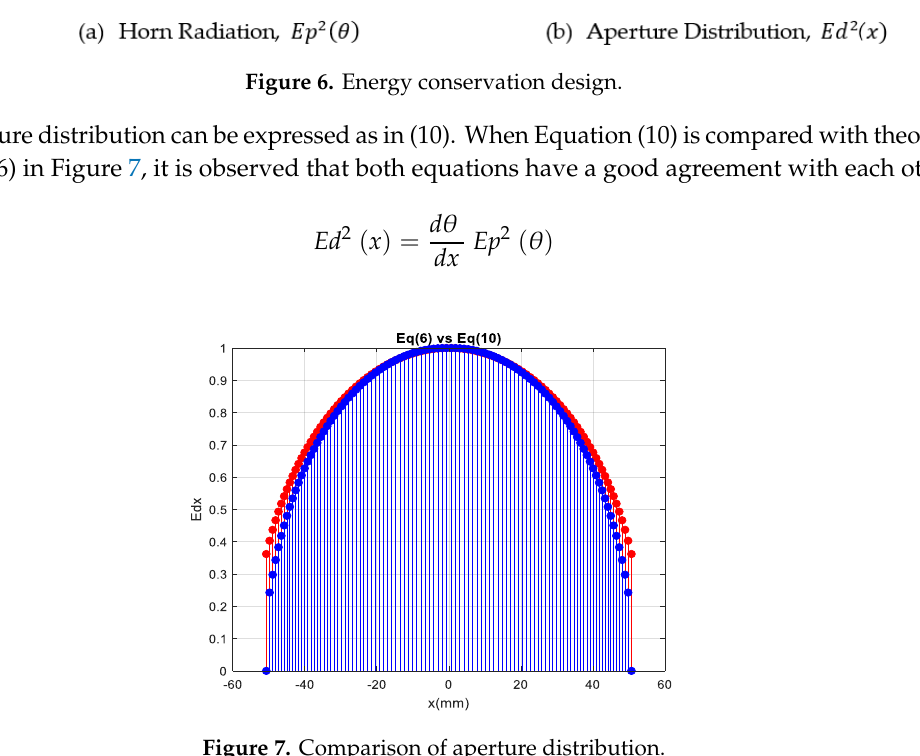
Figure 8. Shaped lens . Table 2. Lens parameters. Parameters